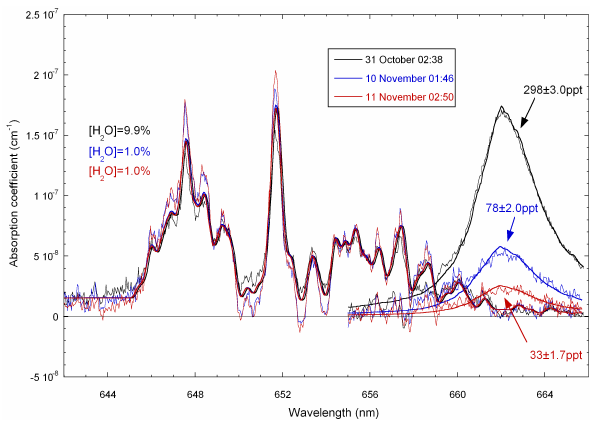
Fig. 3. Three example 15s absorption spectra from REPARTEE-II depicting the NO 3 absorption feature at 662nm and the polyad vi- brational overtones of water vapour. Features from the same spec- trum are coded by colour and dated as indicated on the plot. Derived NO 3 +N 2 O 5 mixing ratios by volume as indicated on plot take into account different mirror R values but are prior to inclusion of the in- let loss conversion factor. Absorption coefficient=0 line shown for